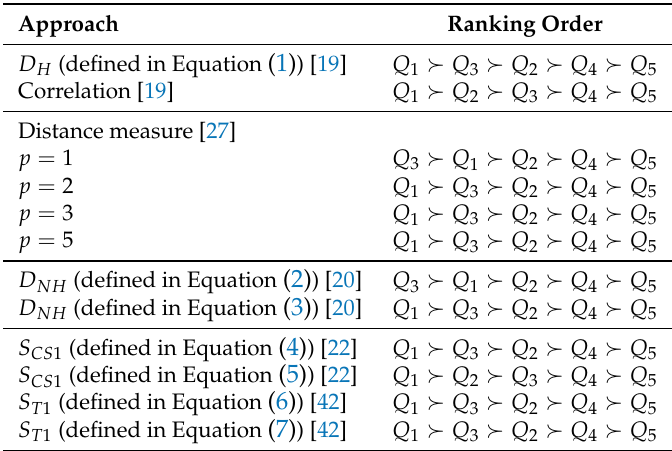
Table 2. Comparison of diagnosis result using existing